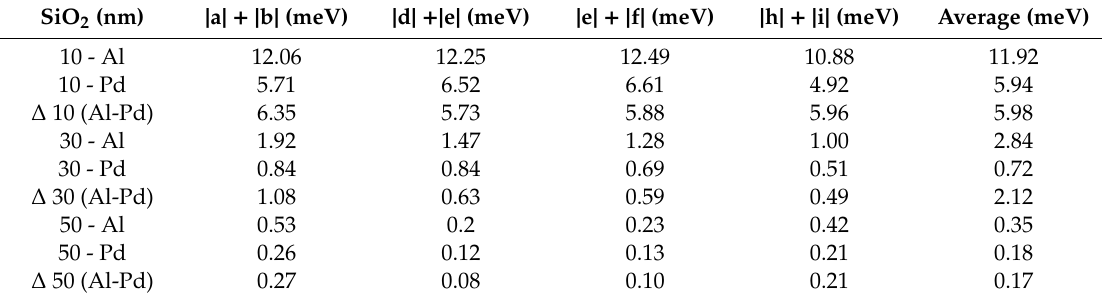
Table 3. Changes in magnitude of the conduction band peaks (a, c, e, g, and i) and valleys (b, d, f, and h) based on Figure 4d. Energy di ff erences between Al and Pd are calculated for SiO 2 at 10 nm, 30 nm, and 50